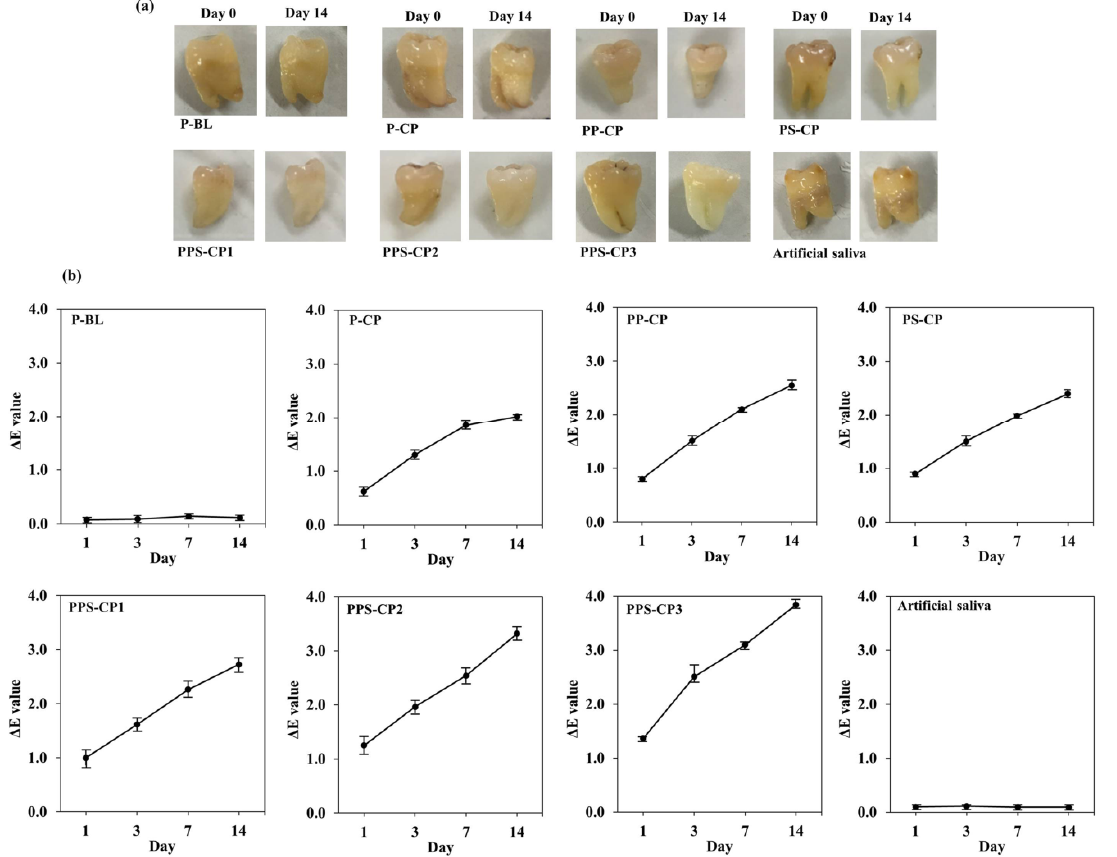
Figure 8. Ex vivo tooth bleaching efficiency of ENFs in comparison with negative control groups; photographs of tooth sample before and after completing the bleaching protocol ( a ) and the mean ΔE values progression for 14 days ( b ).